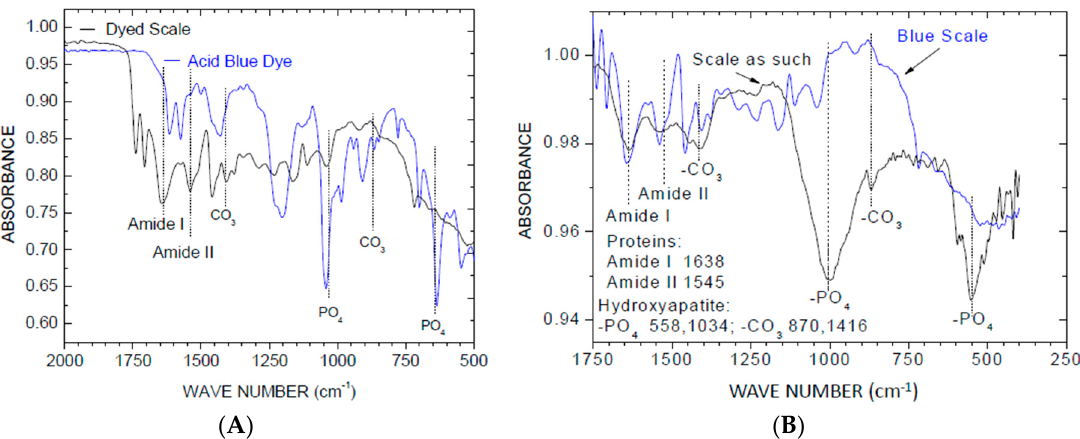
Figure 1. FTIR spectra of the blue colored fish scale and the AB45 dye used for scale coloration ( A ), and the pristine (as such) fish scales (FS) and of the blue colored scale ( B ).